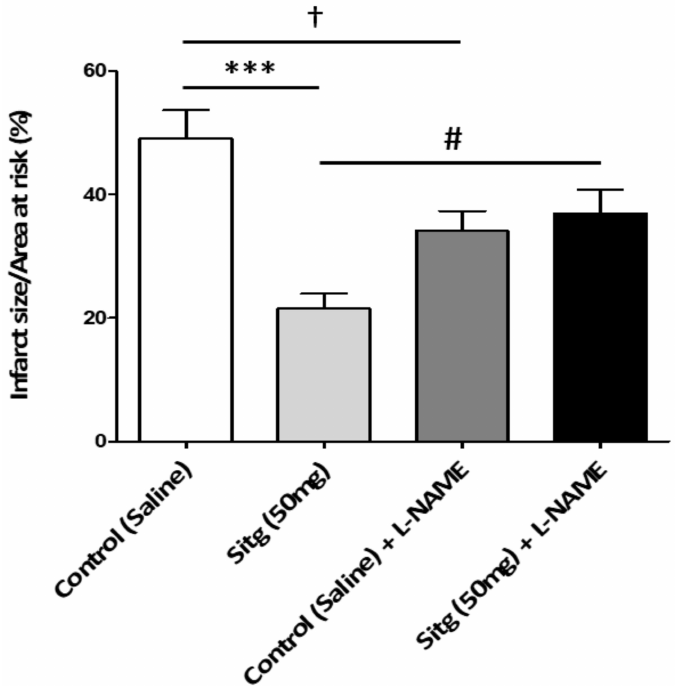
Figure 9. Loss of cardioprotective effect mediated by NOS and increase in infarct size with intraperitoneal injection of NOS-inhibitor ( L -NAME), infarct size expressed in (%). Comparing Control (Saline, n = 12) and Sitagliptin (Sitg (50 mg), n = 10) groups shows a significant decrease in infarct size (*** p < 0.001), while this protective effect was abolished comparing the Sitg (50 mg) + L -NAME (Sitagliptin 50 mg + N ω -Nitro- L -arginine methyl ester hydrochloride (i.p), n = 11) group with the Sitg (50 mg, n = 10) treated group (# p < 0.05), which means that cardioprotective effect of Sitagliptin against infarction is mediated through NOS. A significant decrease († p < 0.05) in infarct size was also observed in Control (Saline) + L -NAME (Saline + N ω -Nitro- L -arginine methyl ester hydrochloride (i.p), n = 11) group, compared to Control (Saline). Data plotted as (Mean ±